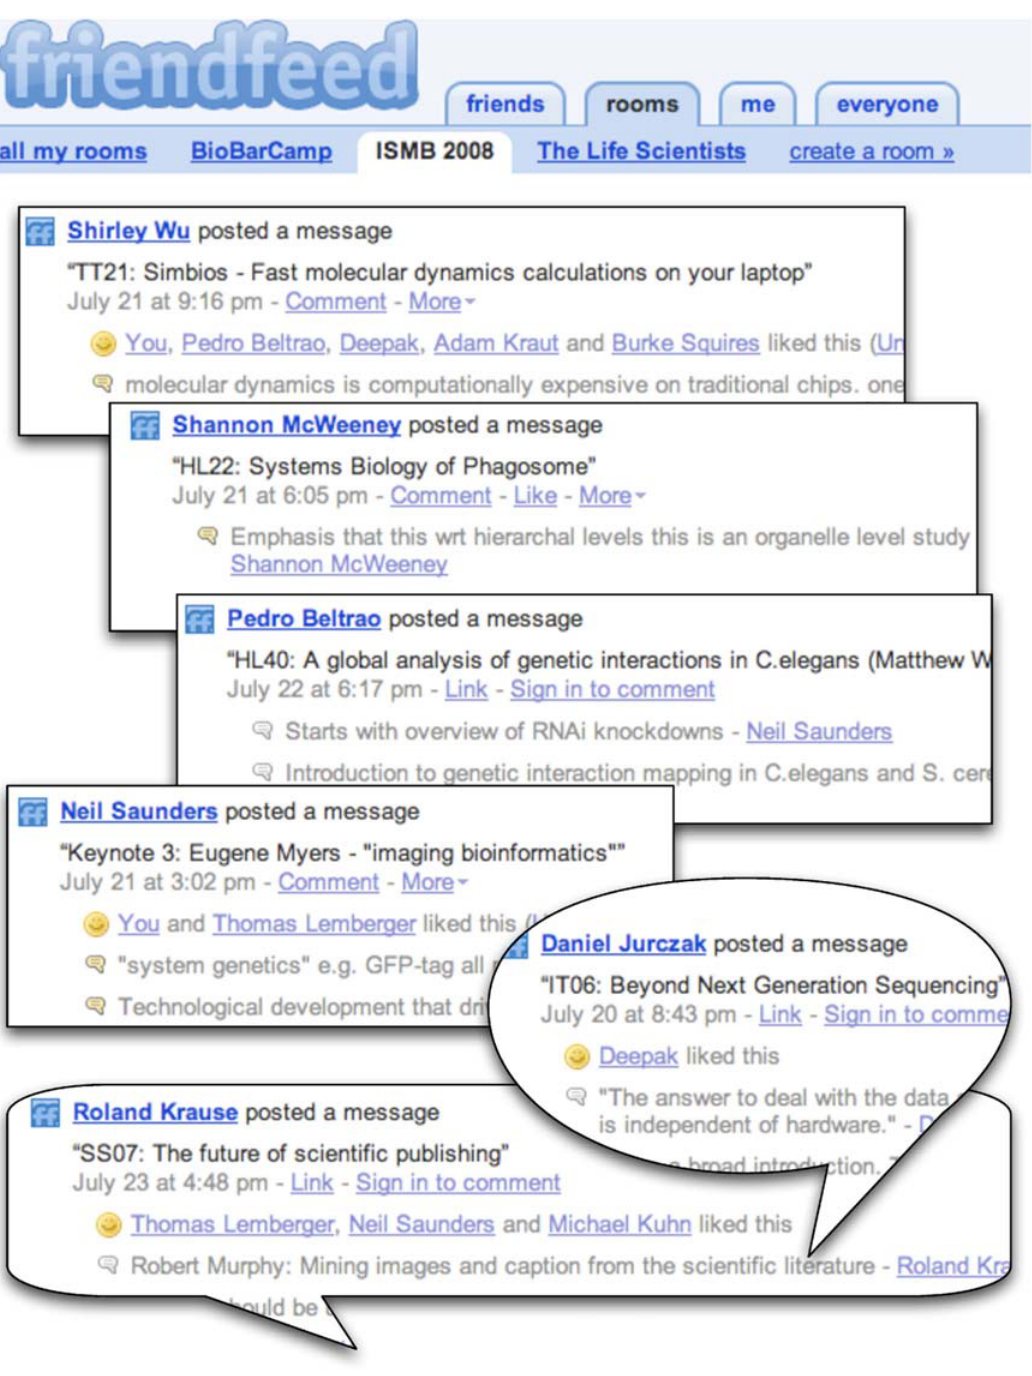
Figure 1. A collage of conversations from the FriendFeed ISMB 2008 room